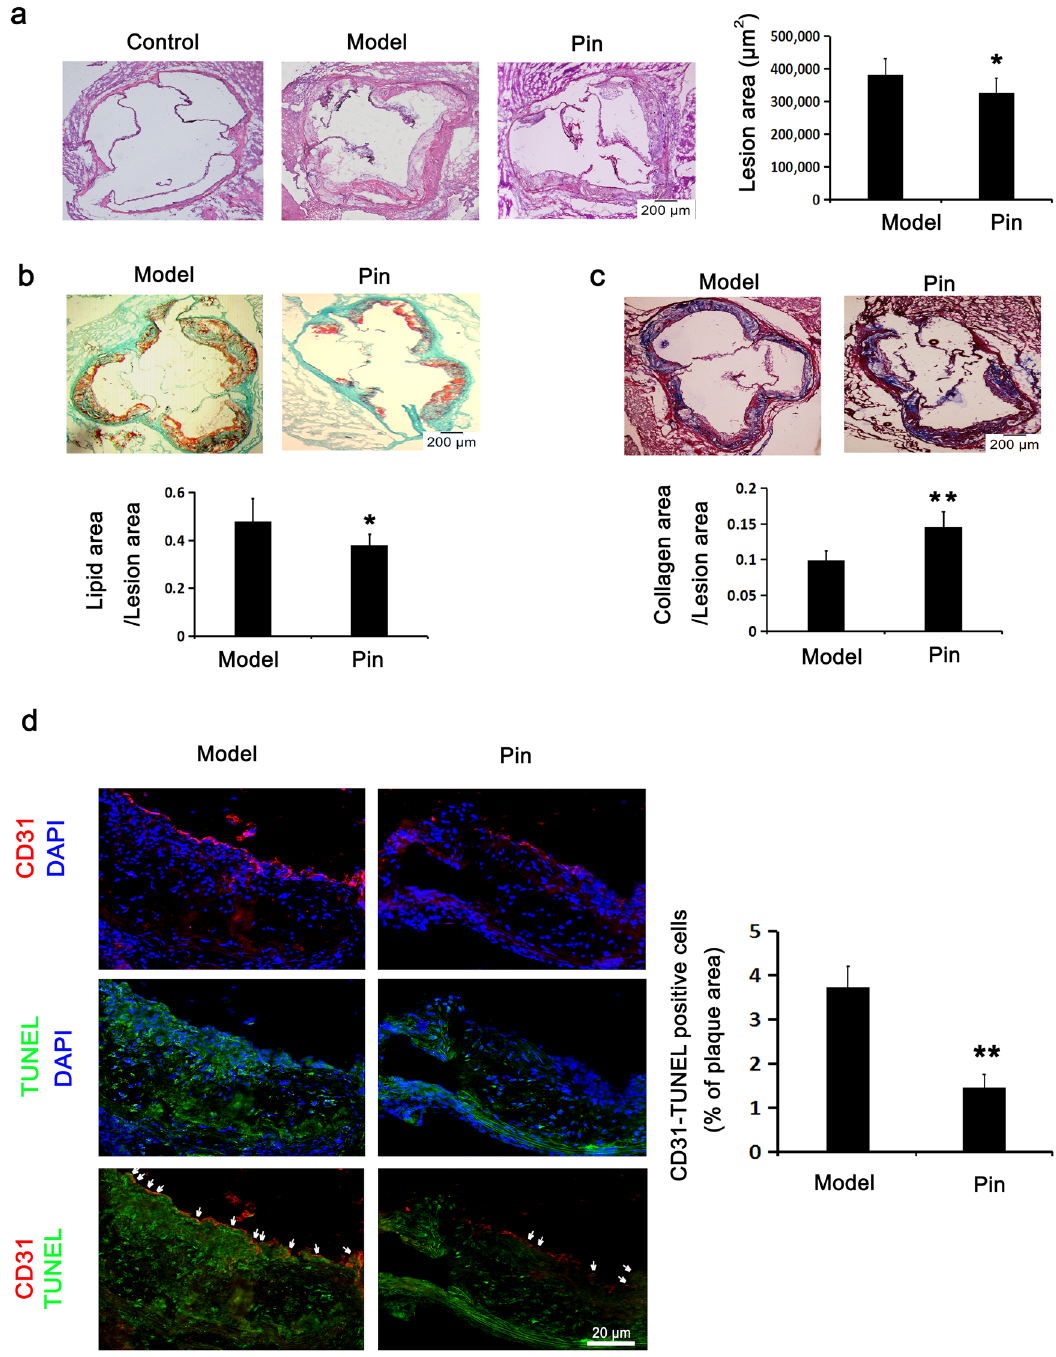
Figure 7. Role of Pin in atherosclerotic lesions and CD31-TUNEL-positive cells in Apoe –/– mice. The atherosclerotic lesion model of Apoe −/− mice fed a high-fat-diet was established and then intragastrically administered with the vehicle (model group) and pinocembrin (Pin group, 20 mg/kg), once daily for continuously 14 weeks. In addition, a normal chow diet was fed to male C57BL/6 mice as the background control of Apoe −/− mice. ( a ) HE-stained aortic root cross-sections to examine the atherosclerotic lesion formation. Scale bar = 200 µm. ( b ) Lipid content stained by oil O red and bright green. Scale bar = 200 µm. ( c ) Collagen content stained by Masson. Scale bar = 200 µm. ( d ) Representative fluorescence micrographs depicting the CD31 and TUNEL staining images for endothelial cell with DNA damage in the aortic roots. Red: CD31; Green: TUNEL; Blue: nuclei. Scale bar = 20 µm. Data are described with mean ± SD of at least 3 different experiments. * P < 0.05; ** P < 0.01 vs. model